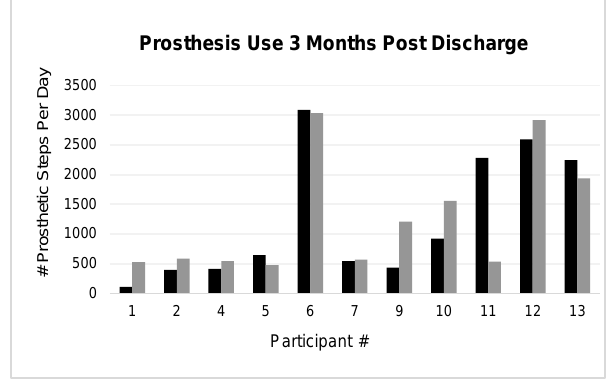
Figure 1: Daily average number of steps on the prosthesis at T1 (black) and T2 (grey).